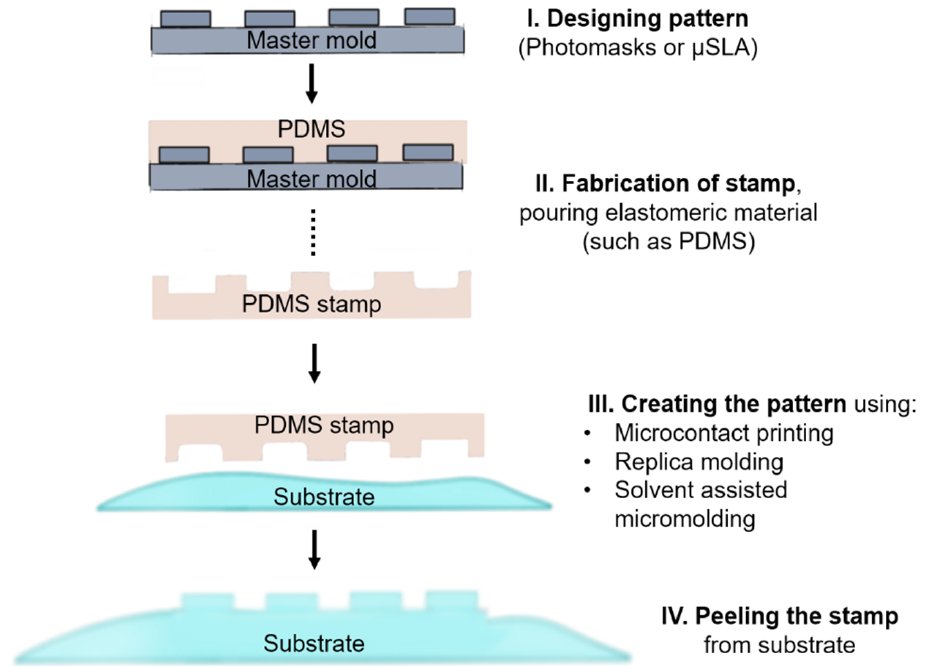
Figure 3. Soft lithography fabrication diagram. First, a master mold is created normally using a silicon wafer. The CAD pattern is printed on the surface of the master mold using µSLA. Once completed, the elastomeric material is poured, and a stamp is created. This stamp is used to create a pattern on the substrate surface. The patterning technique depends on the selected substrate, which is chosen according to the application. Finally, the stamp is peeled from the substrate.